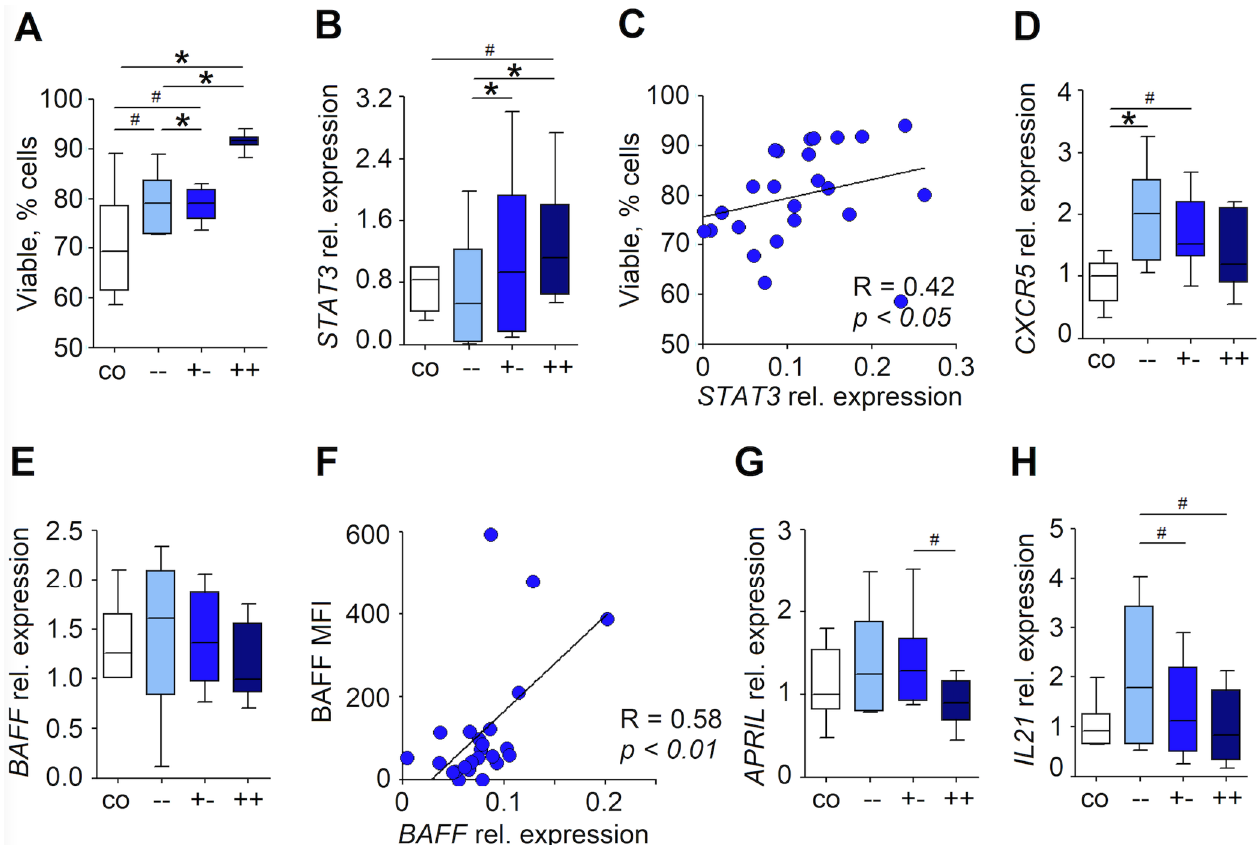
Figure 2. The RLN tissue microenvironment supports the N BH properties of infiltrating neutrophils. Neutrophils isolated from healthy donors ( n = 6) were cultured with cell-culture media and LN supernatants. DMEMc (co, white), non-metastatic LN supernatant ( −− , light blue and + − , blue) and metastatic LN supernatant (++, dark blue). ( A ) Survival of neutrophils that are cultured in DMEMc (co, white), non-metastatic LN supernatant ( −− , light blue and + − , blue) and metastatic LN supernatant (++, dark blue). ( B ) STAT3 gene expression, relative to the BACTIN housekeeping gene, in neutrophils. Cells were cultured with cell-culture media and LN supernatants. DMEMc (co, white), non-metastatic LN supernatant ( −− , light blue and + − , blue) and metastatic LN supernatant (++, dark blue). ( C ) Correlation between neutrophil survival and STAT3 expression relative to BACTIN . ( D ) CXCR5 gene expression, relative to the BACTIN housekeeping gene, in neutrophils. Wilcoxon test for dependent samples. ( E ) BAFF gene expression, relative to BACTIN housekeeping gene, in neutrophils. Cells were cultured with cell-culture media and LN supernatants. DMEMc (co, white), non-metastatic LN supernatant ( −− , cyan and + − , blue) and metastatic LN supernatant (++, dark blue). ( F ) The correlation between the surface expression of the BAFF protein and BAFF gene expression relative to BACTIN . ( G ) APRIL gene expression, relative to the BACTIN housekeeping gene, in neutrophils. Cells were cultured with cell-culture media and LN supernatants. DMEMc (co, white), non-metastatic LN supernatant ( −− , cyan and + − , blue) and metastatic LN supernatant (++, dark blue). ( H ) IL21 gene expression, relative to the BACTIN housekeeping gene, in neutrophils. Cells were cultured with cell-culture media and LN supernatants. DMEMc (co, white), non-metastatic LN supernatant ( −− , cyan and + − , blue) and metastatic LN supernatant (++, dark blue). Correlations were analyzed with a Spearman R test. Data are shown as median, 25–75 percentiles, min-max, * p < 0.05, # p =